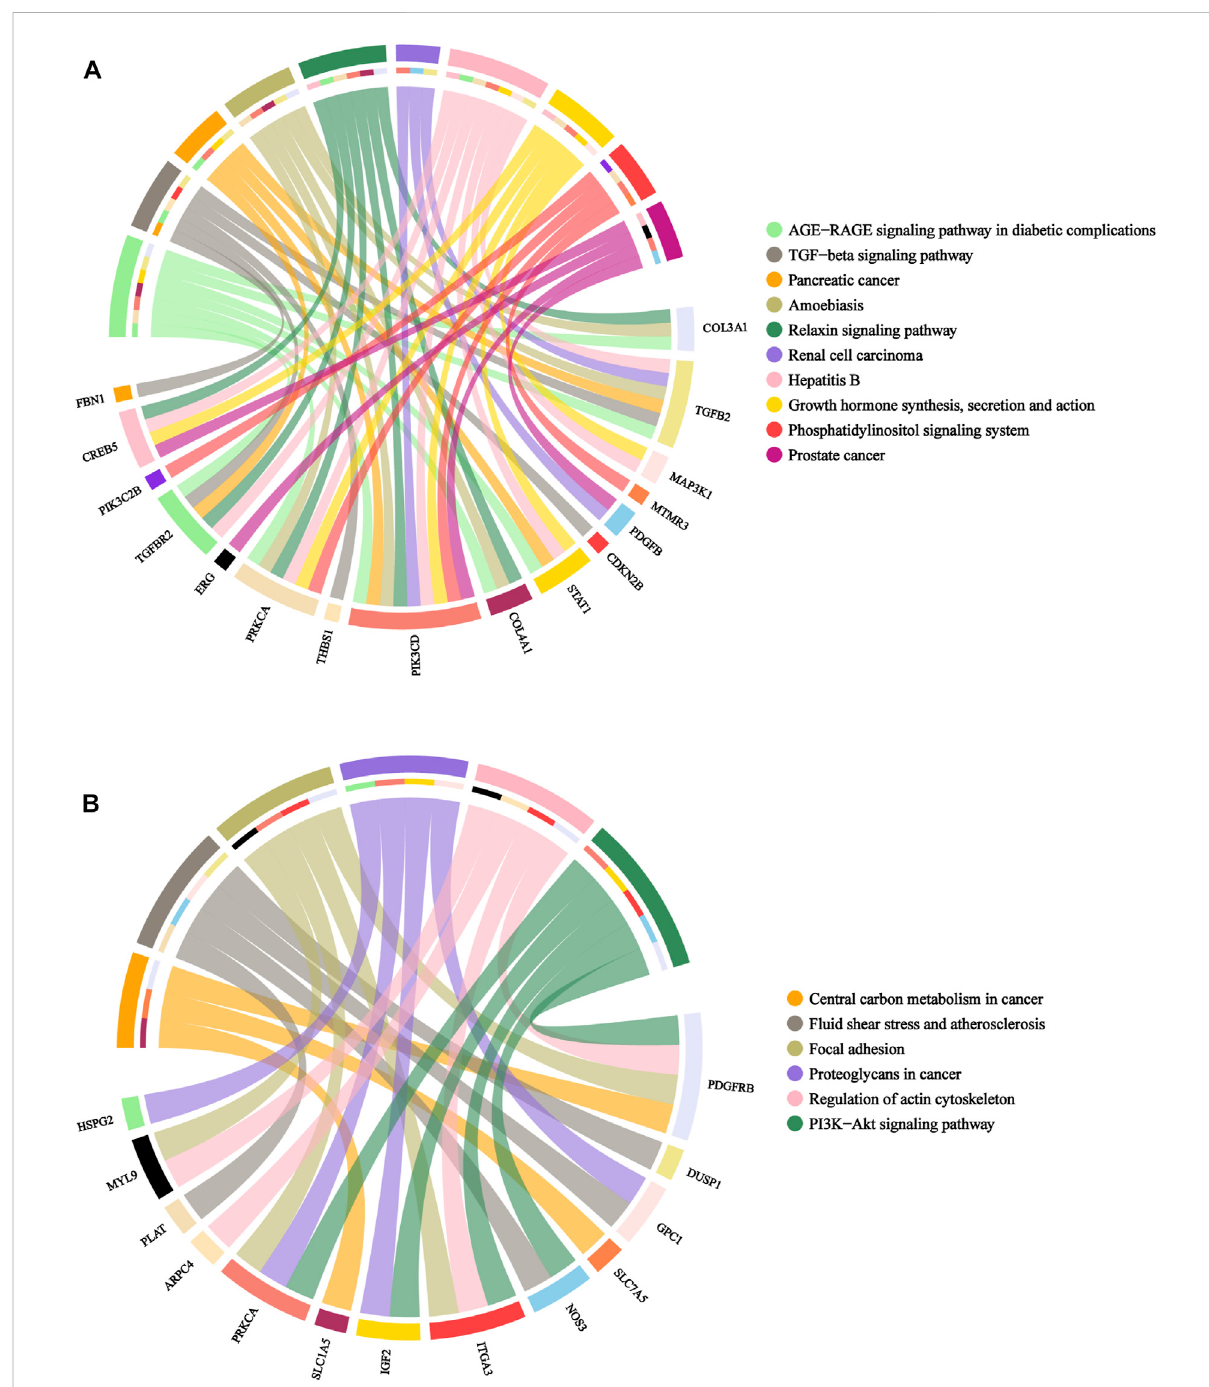
FIGURE 6 Chord diagram of KEGG pathway analyses for candidate genes. (A) : upregulated genes. (B) : downregulated genes. Legend: pathway